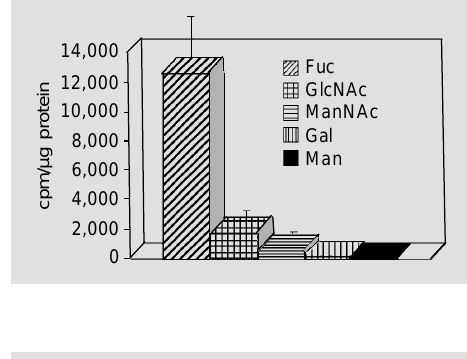
Figure 2 - Specific activity of rab- bit vitreous proteins 40 h after intravitreal injection of [ 3 H]-fu- cose ([ 3 H]-Fuc) (20 µCi), [ 3 H]-pro- line ([ 3 H]-Pro) (100 or 20 µCi), [ 3 H]-tyrosine ([ 3 H]-Tyr) (100 or 20 µCi) or a [ 3 H]-amino acid mixture ([ 3 H]-aa) (100 or 20 µCi). Data are reported as means ± SD for 5